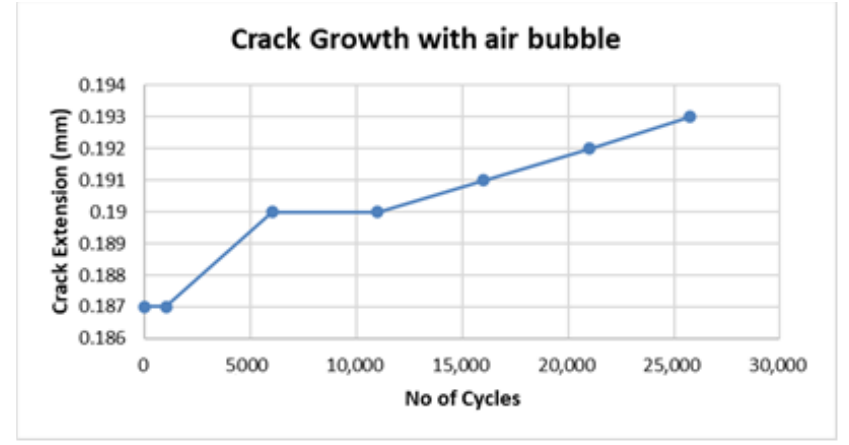
Figure 6. Crack growth due to inhomogeneity. Fractography using an optical microscope revealed that air bubbles were trapped within adhesive during fabrication. The presence of these air bubbles decreased the bond strength. In fractography images shown in Figure 7, circled areas show the presence of air